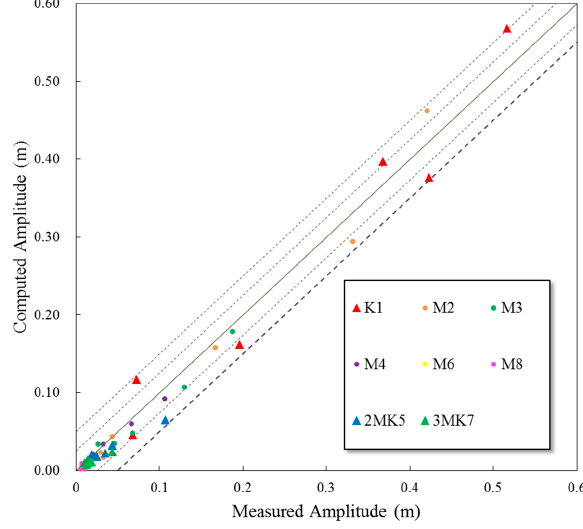
Figure 4. Comparison of harmonic constituent amplitudes, with difference bands located at 0.025 and 0.05 m.